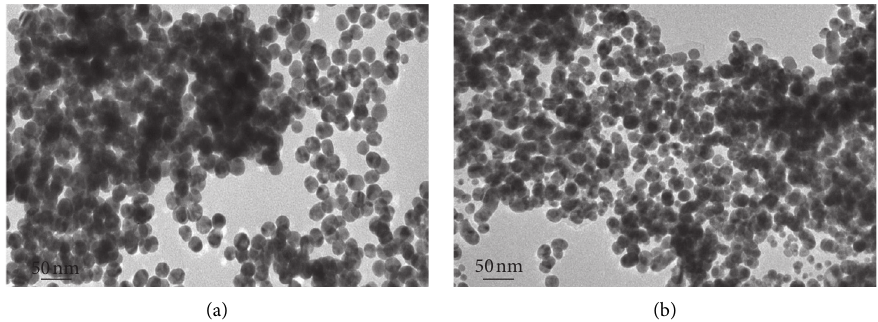
Figure 9: HRTEM images for (a) Ac-Cit-HAuNPs and (b) Ac-Cit-MAuNPs at 50000x